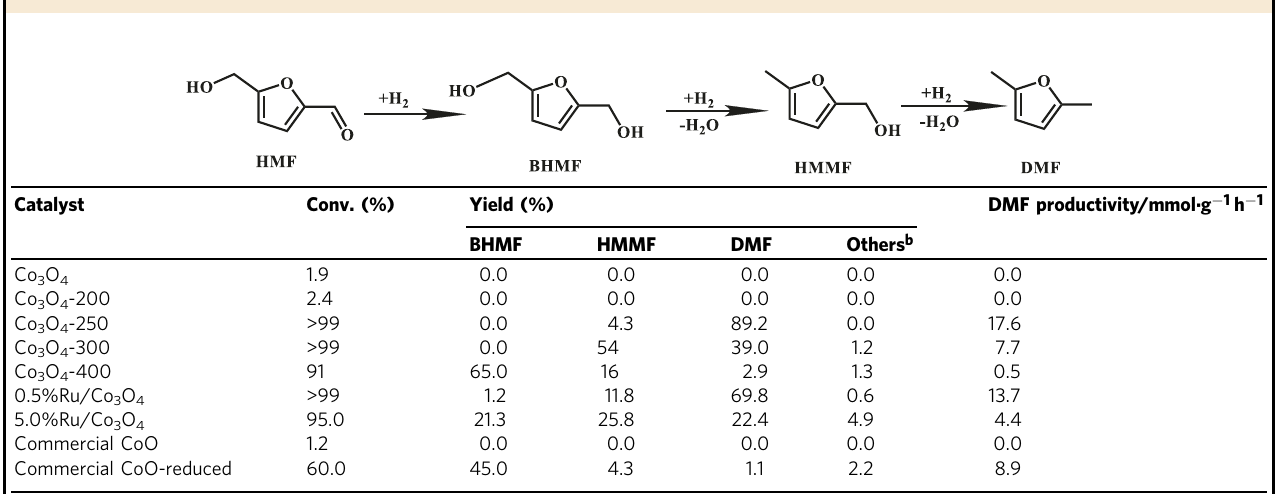
Table 1 Summary of results of conversion of HMF over different Co-based catalysts a .